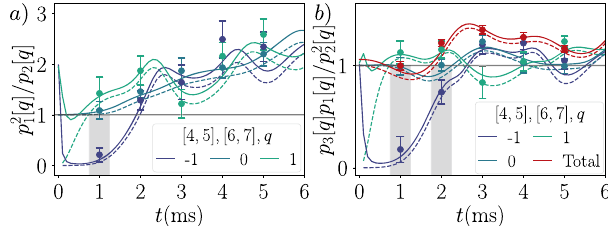
Fig. 4 Experimental SR-entanglement detection in a trapped ion quantum simulator using data obtained in ref. 28 . For a total system of N = 10 spins and subsystem A , B = [4, 5], [6, 7], we present in a) the SR- D 2 ratio and b) SR- p 3 -PPT ratio as a function of time for various symmetry sectors . In both panels, entanglement is detected in regimes where the corresponding global conditions do not reveal entanglement, as indicated in the shaded grey areas (values below unity). The points with error bars correspond to the values and uncertainties extracted from the experimental data from ref. 28 , whereas the dashed (solid) lines are theoretical simulations of unitary dynamics (taking decoherence effects into account), as detailed in refs. 28,34